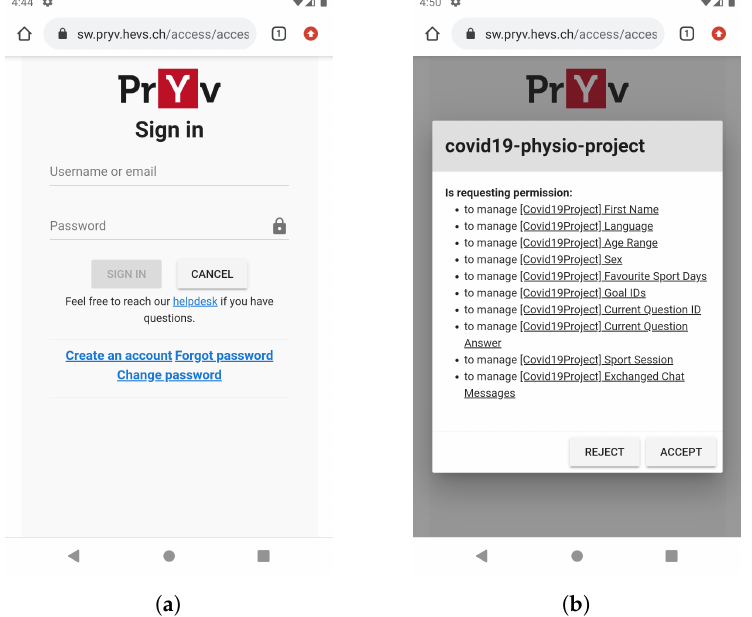
Figure 7. Interfaces for registration, login, and granting access to personal information. ( a ) Pryv interface to login and register. ( b ) Description of the privacy grant for Pryv